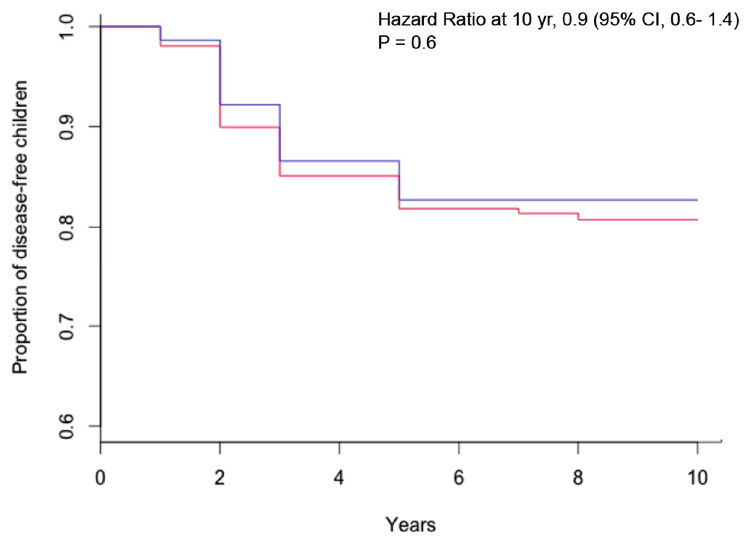
Figure 2. Kaplan–Meier estimates of celiac disease, according to breastfeeding duration (red = breastfeeding < 6 months; blue = breastfeeding ≥ 6 months).